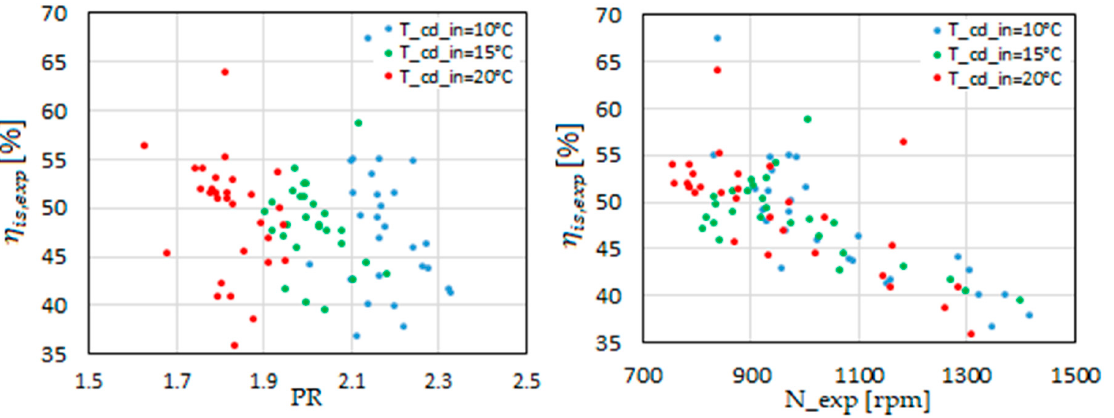
Figure 6. Scroll expander isentropic efficiency with pressure ratio (PR) ( left ), and with shaft speed ( right ).